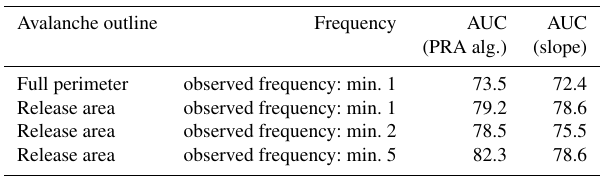
Table 2. Area under the curve (AUC) for the PRA algorithm and slope